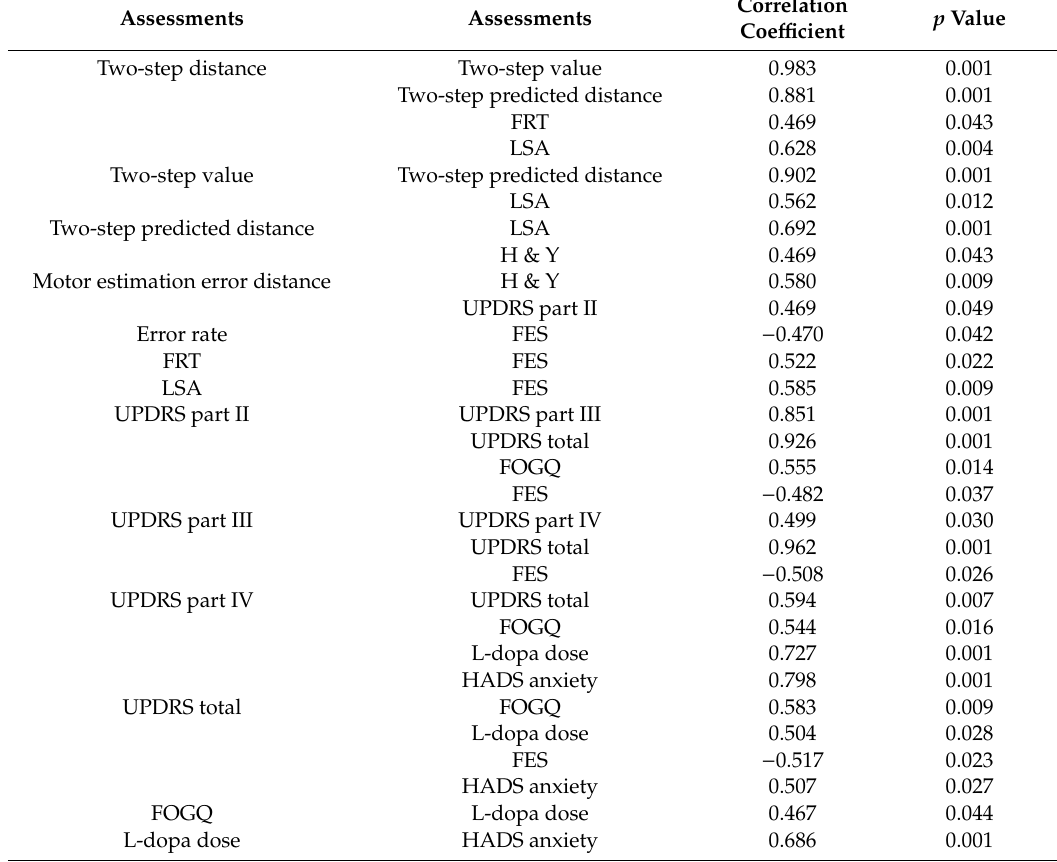
Table 3. Correlation coe ffi cients for patients with Parkinson’s disease.